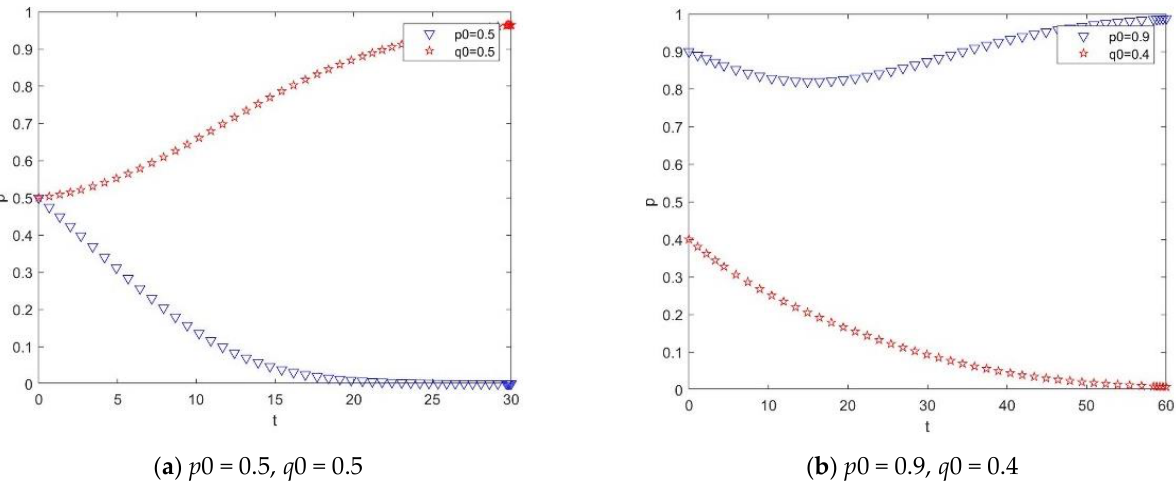
Figure 2. The effect of different initial proportions on the evolution